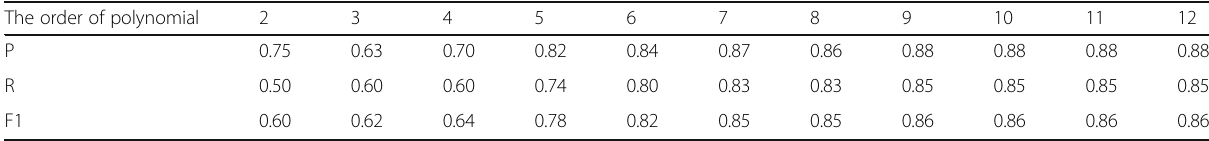
Table 3 The influence of the order of vanishing component polynomial in the VCA method on the classification performance The order of polynomial 2